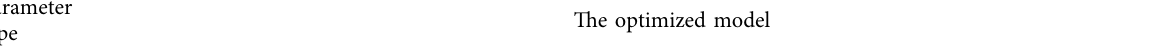
Table 1: Parameter